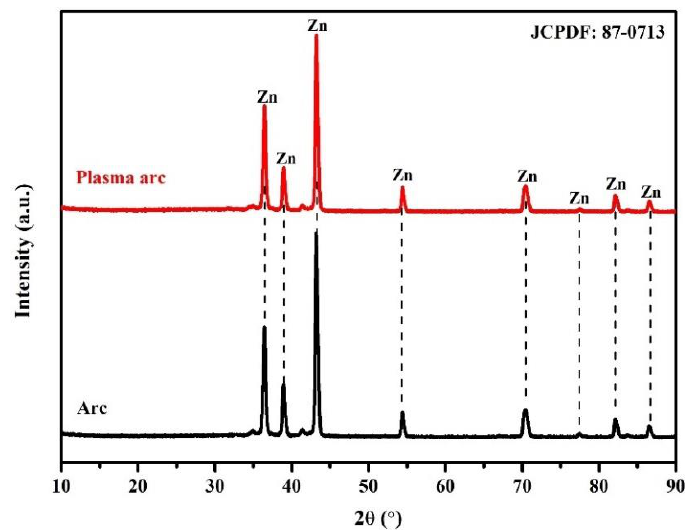
Figure 5. XRD patterns of the Zn coatings deposited by different processes.